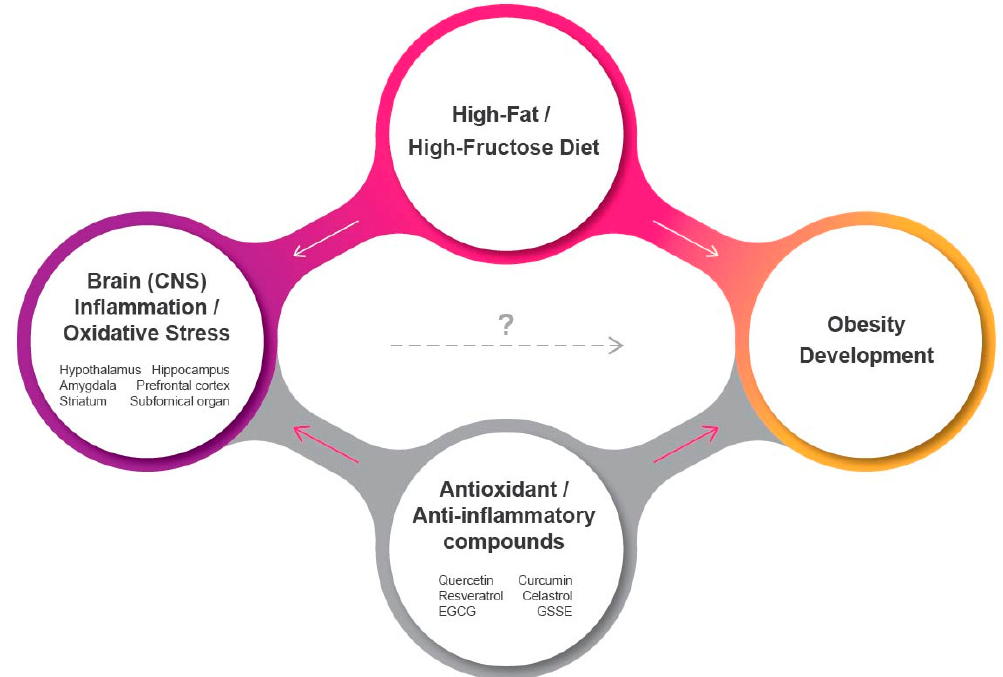
Figure 1. Effects of energy-dense, palatable foods on CNS inflammation and oxidative stress and obesity. White and red arrows indicate stimulatory and inhibitory, respectively. A potential causal link exists between oxidative stress and inflammation in the CNS and induction of obesity following consumption of a high-fat/high-fructose diet. EGCG: epigallocatechin-3-gallate; GSSE: grape seed and skin extract.